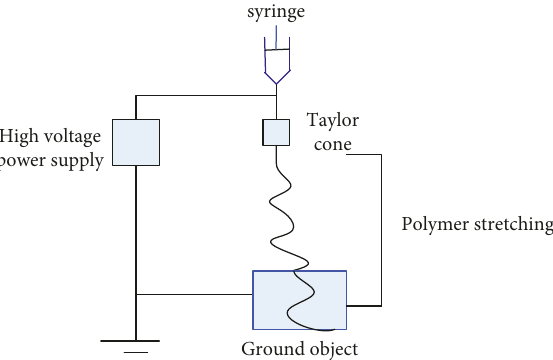
Figure 5: Flow chart of nanofibers produced by electrospinning technology.